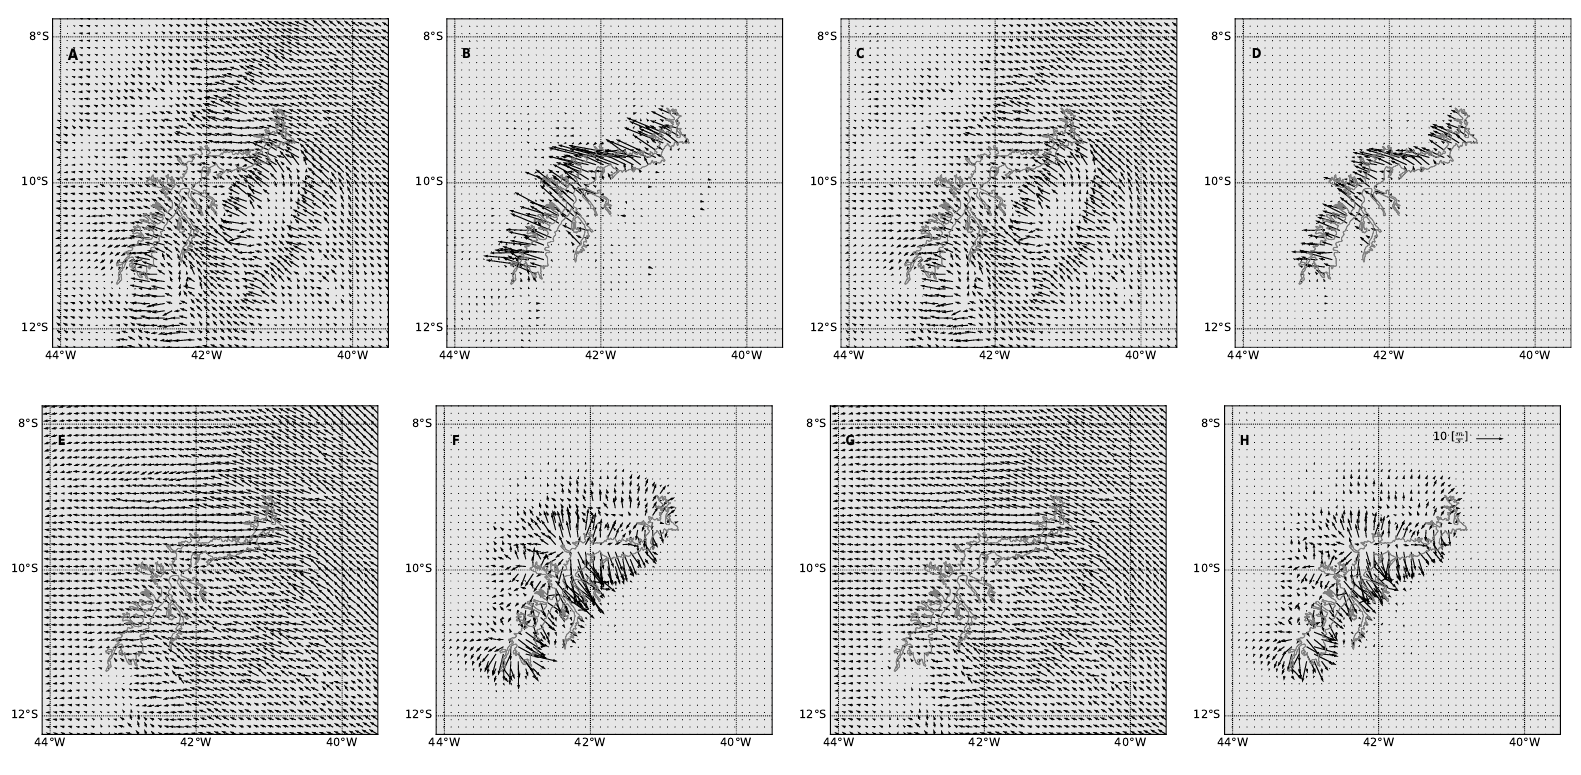
Figure 8. Characteristic wind velocities at 3 m above the ground at ( A , B , C , D ) 3:00 a.m. and ( E , F , G , H ) 3:00 p.m. for ( A , C , E , G ) the situation without the lake and ( B , D , F , H ) differences for the simulations with the lake in comparison with the control run without the lake. The results correspond to the periods ( A , B , E , F